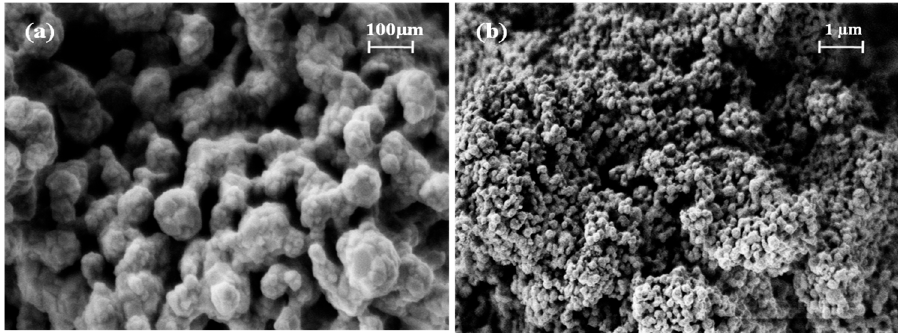
Figure 3. SEM images of the S3 powder at the ( a ) 150 k× and ( b ) 30 k× magnification levels.